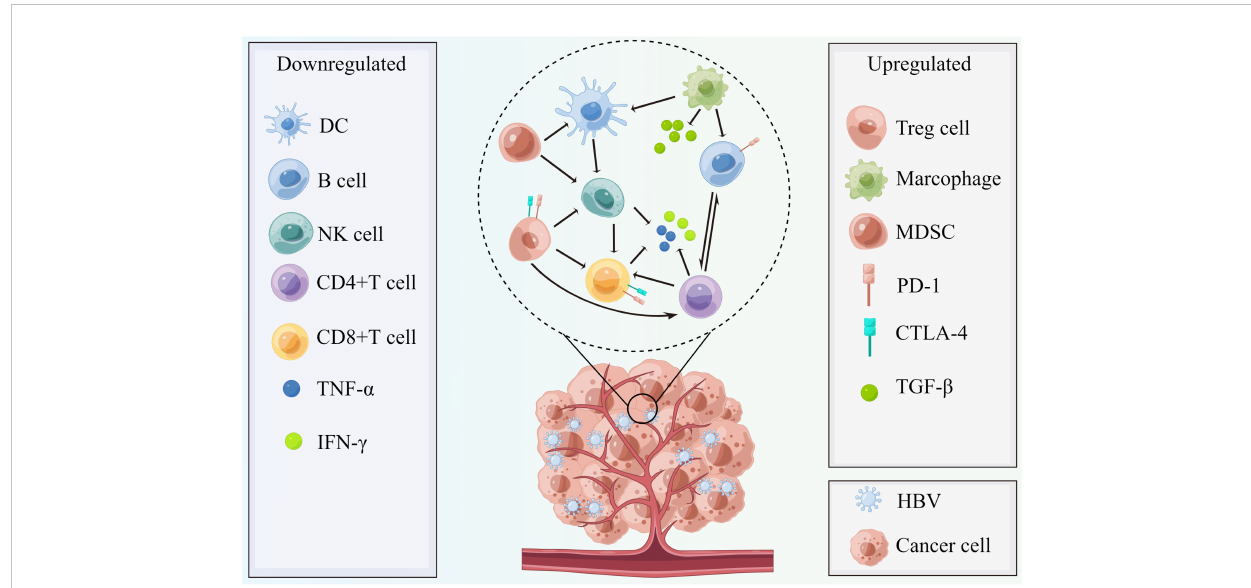
FIGURE 3 The chronic HBV-mediated tumor microenvironment with characteristics of more immunosuppressive conditions. In HBV infection conditions, the host immune status becomes more immunosuppressive and is characterized by weakening of stimulatory signal (DC, TNF- a , and IFN- g ), enhancement of inhibitory signals (TGF- b ), decreased quantity of NK cells, and B cells, as well as effector T cells (CD4+ and CD8+T cell) and enrichment of Tregs cells, myeloid-derived suppressor cells, and M2 macrophage polarization. Therefore, the activated PD-1/PD-L1 pathway plays a suppressive role to help cancer cells ’ immune escape and invasion and the CTLA-4 pathways also contribute to this process. This fi gure was drawn with the tool “ Figdraw ” by Dr. Yu Min. DC, dendritic cells; MDSC, myeloid-derived suppressor cells; PD-1, programmed cell death protein 1; CTLA-4, cytotoxic T-lymphocyte – associated antigen; TGF- b , transforming growth factor- b ; NK cells, nature killer cells; TNF- a , tumor necrosis factor- a ; IFN- g , interferon g ; HBV, hepatitis B